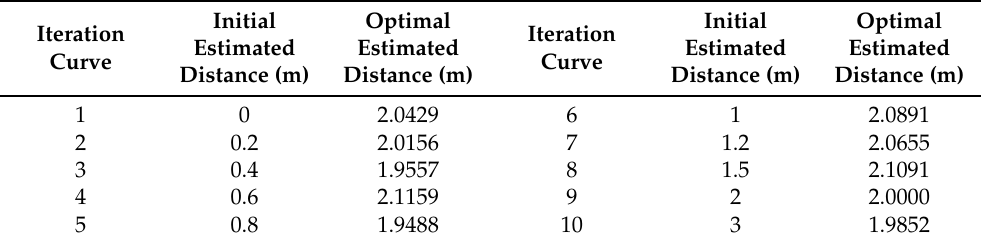
Table 6. The optimal estimated distance of near-field imaging results for different initial estimated distances with a real imaging